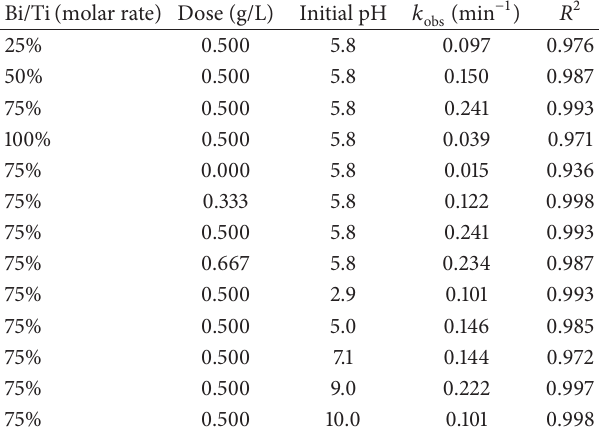
Figure 7: Effect of 75% BiOI-TiO 2 dosage on the degradation of BPA. Initial pH = 5.8, BPA concentration = 20 mg/L. Table 2: The degradation kinetic data under different experimental